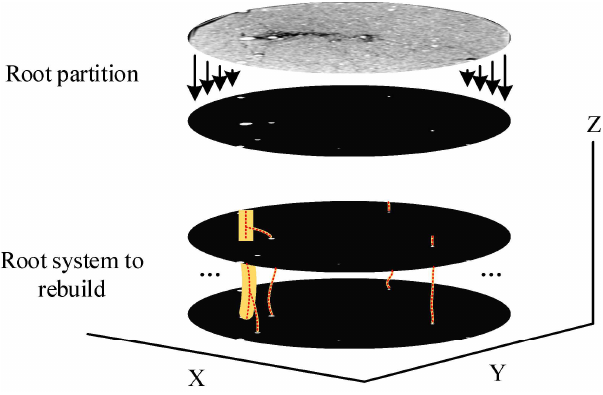
Figure 16. Visualization process model of the sectional image .